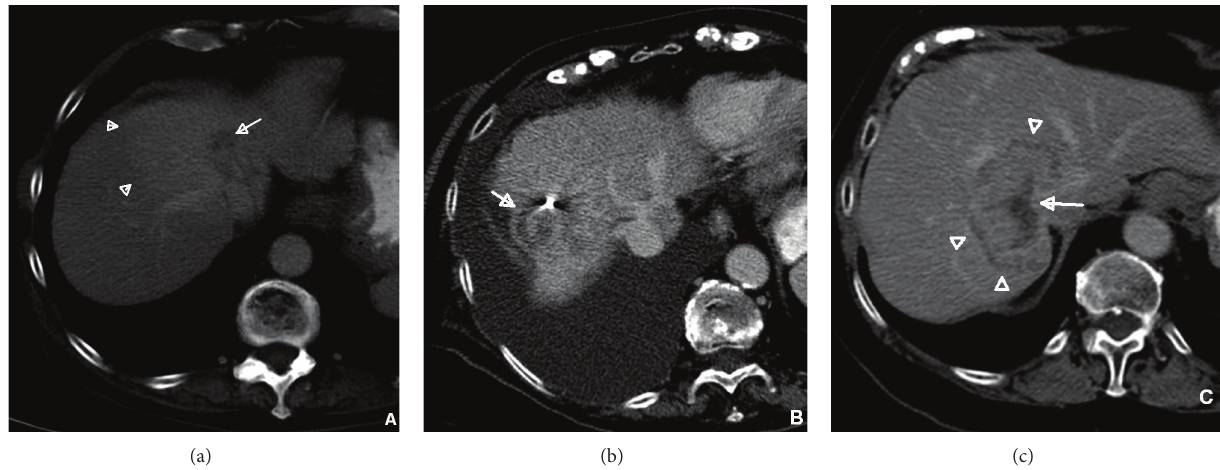
Figure 4: Three types of responses of surrounding liver parenchyma to stereotactic radiotherapy treatment of hepatocellular carcinoma lesions, as seen on delayed imaging: hyperdense halo (a), the most frequent response, followed by isodense liver parenchyma (b), and hypodense halo (c). Arrows are pointing to the treated lesion and arrowheads to the response of the surrounding liver.